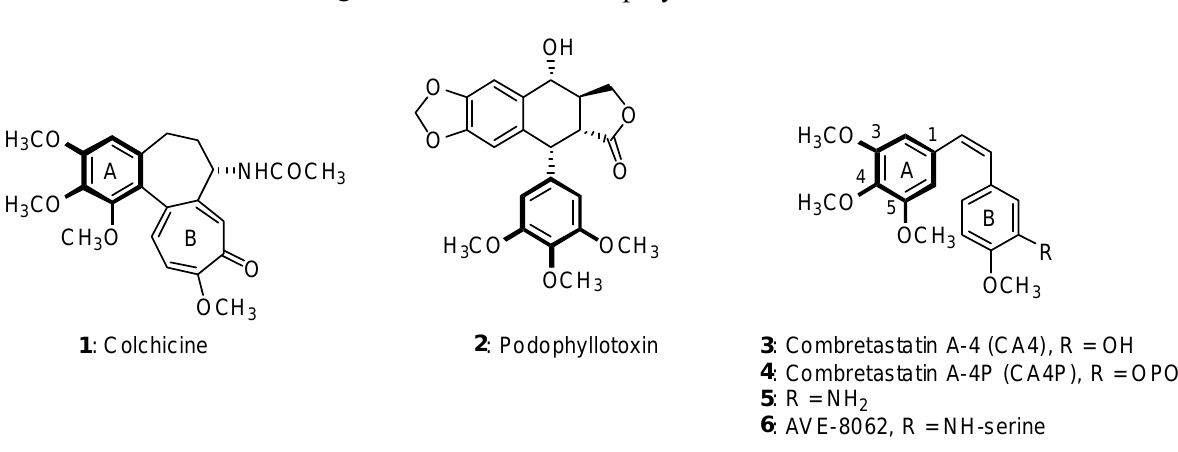
Figure 1. Natural tubulin polymerization